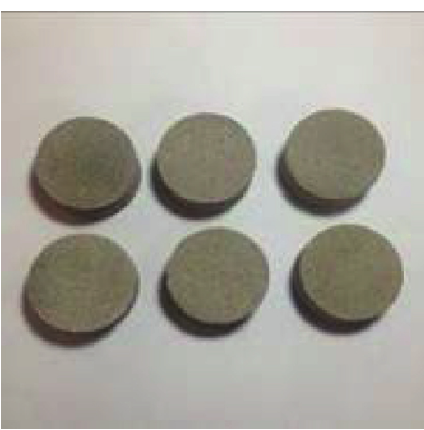
Figure 6: Cemented sand specimen.